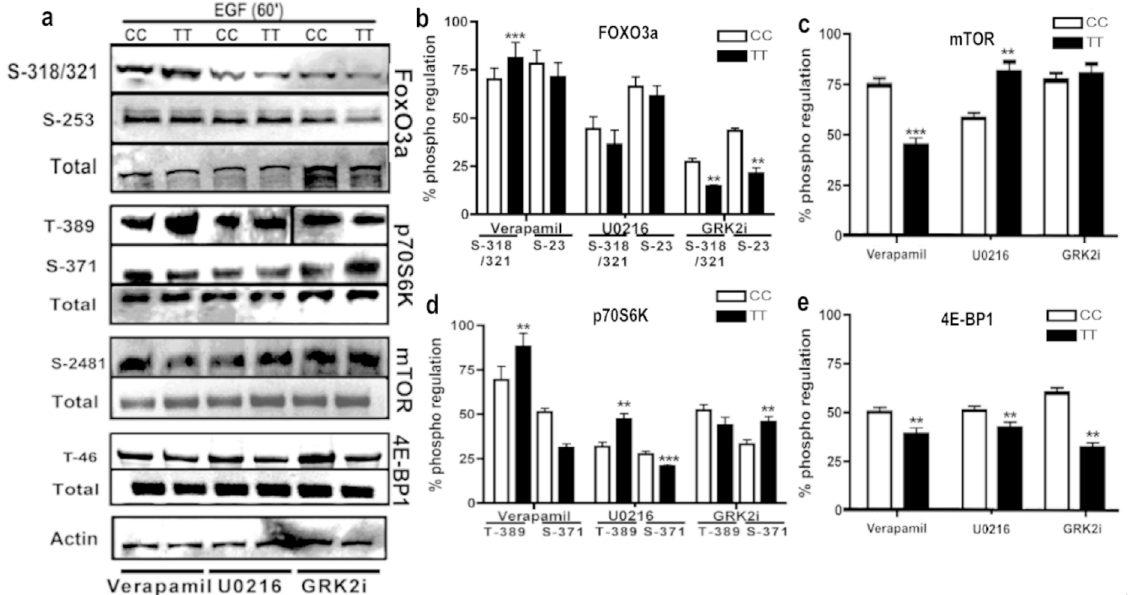
Figure 11. Inhibition of EGF-induced mTOR, 4E-BP1, p70 S6K and Foxo3a signalling in TT and CC lymphoblasts exhibit distinct responses. Phospho immunoreactivity of mTOR, 4E-BP1, p70S 6K and Foxo3a upon treatment with G bg signaling inhibitors shows altered signaling response in TT cells in comparison to CC lymphoblasts. The distinct signaling profiles are confirmed by semi quantitative densitometry analyses. Data presented in all panels are the mean with standard error (bars) of n = 3 independent experiments. Statistical significance is shown as *P<0.05, **P<0.01,